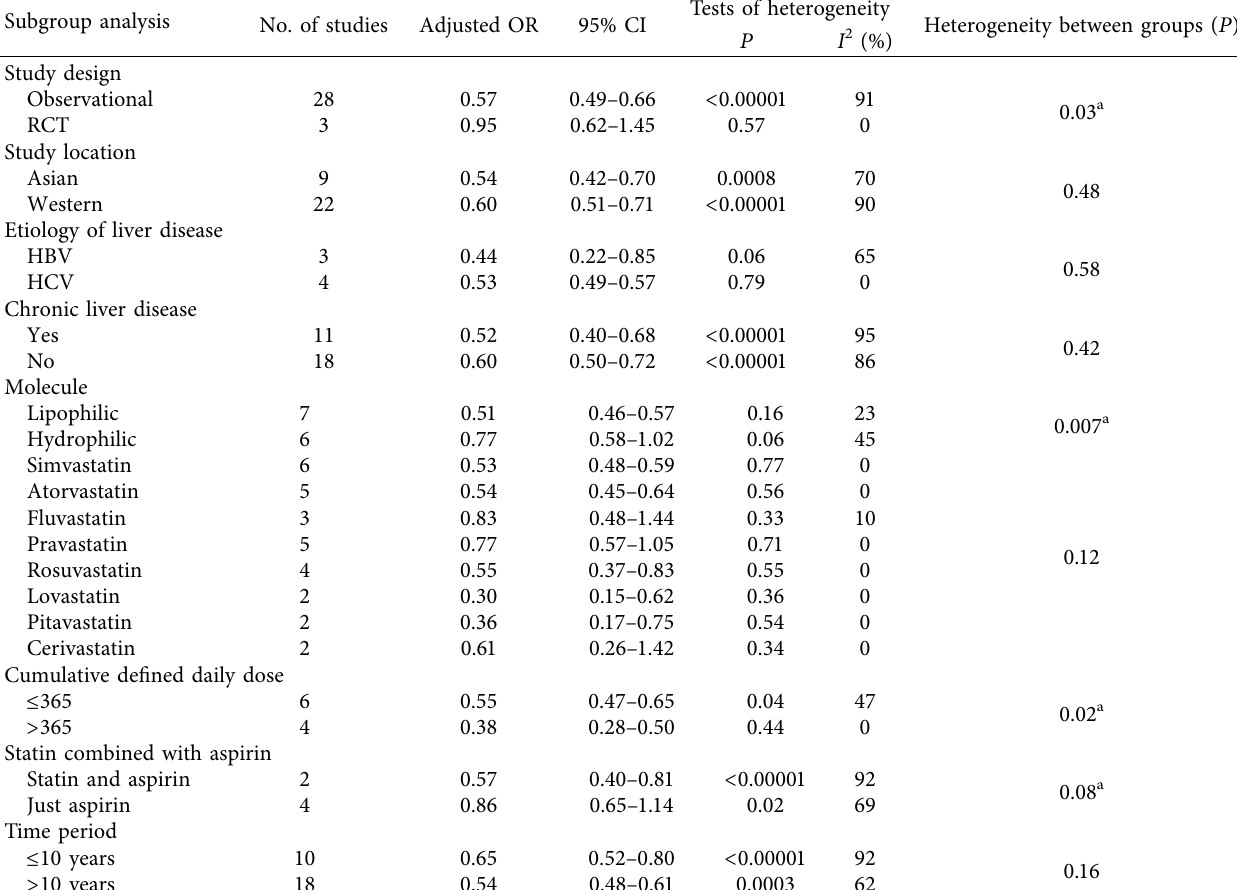
Table 3: Subgroup analysis to examine sources of heterogeneity observed in summary estimate.